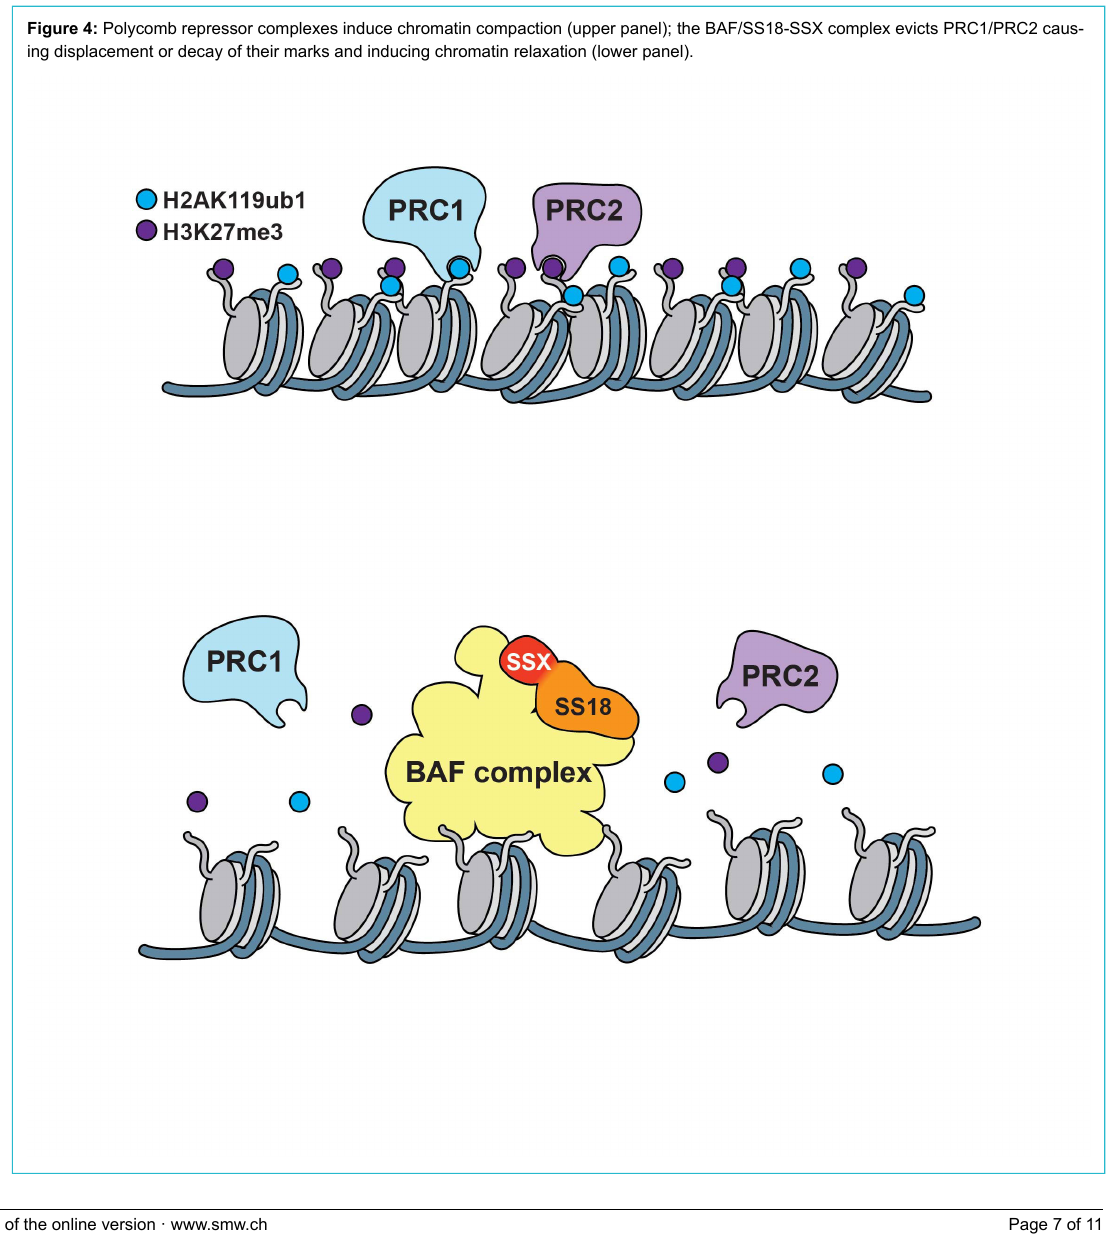
Figure 4: Polycomb repressor complexes induce chromatin compaction (upper panel); the BAF/SS18-SSX complex evicts PRC1/PRC2 caus- ing displacement or decay of their marks and inducing chromatin relaxation (lower